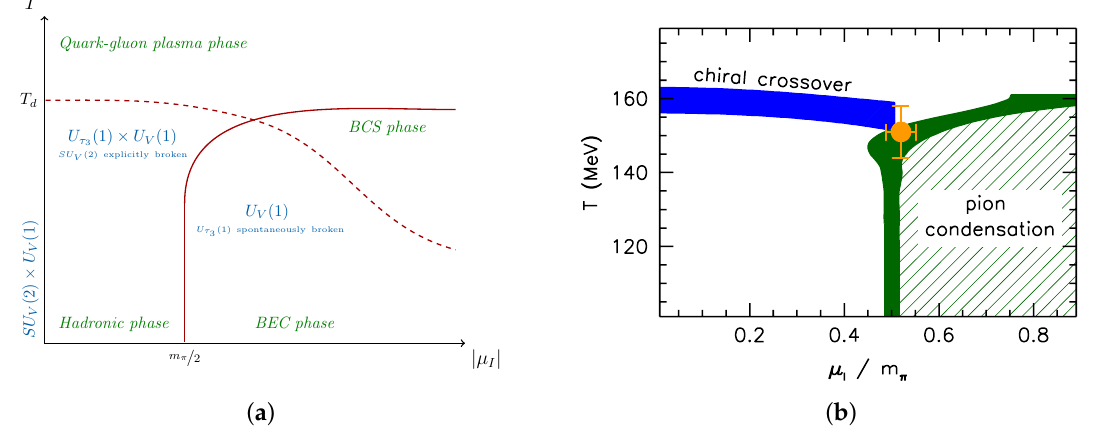
Figure 1. Conjectured ( a ) [1,2] and measured ( b ) [3,4] phase diagram of quantum chromodynamics (QCD) at pure isospin chemical